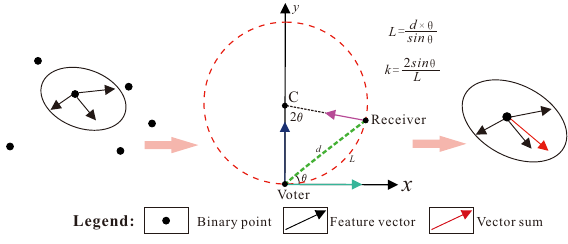
Figure 2. The schematic diagram of voting